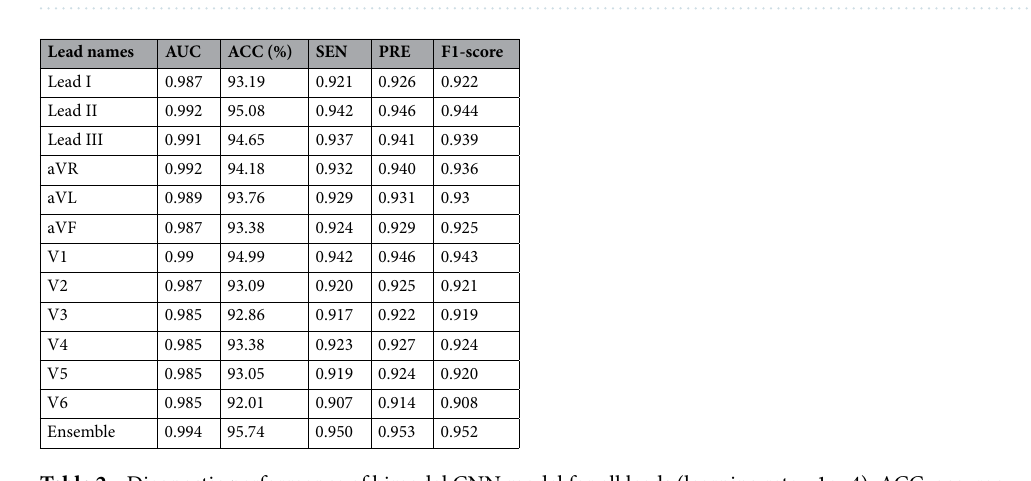
Table 2. Diagnostic performance of bimodal CNN model for all leads (learning rate = 1e−4). ACC, accuracy; SEN, sensitivity; PRE,